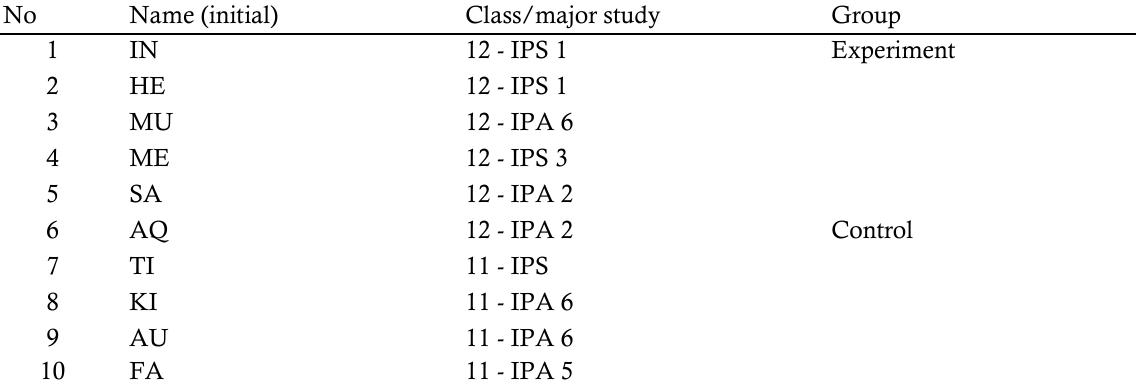
Table 2. List of students identified as having experienced academic burnout and being provided with online group counseling